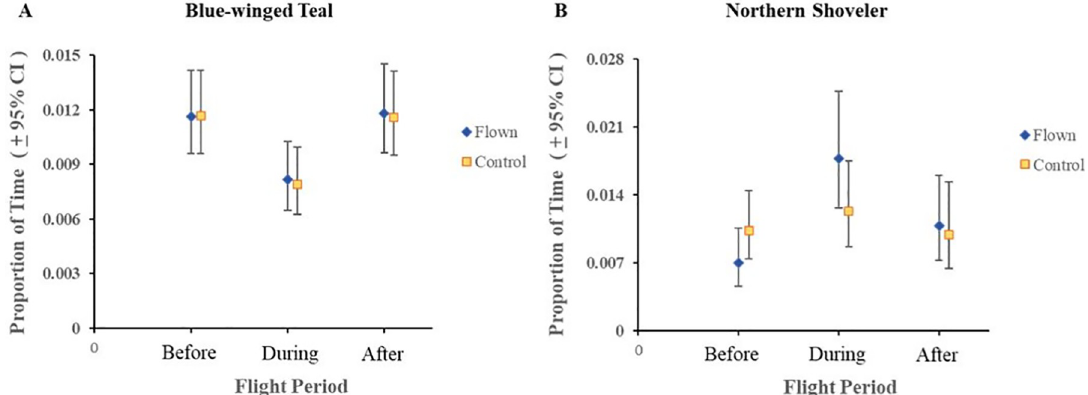
Fig 2. Least square means and 95% confidence intervals of proportion of time spent on vigilant behavior for blue-winged teal (A) and northern shoveler (B) within treatments groups (Flown vs. Control). This behavior consisted of the ducks fully extending their head away from the body to scan for